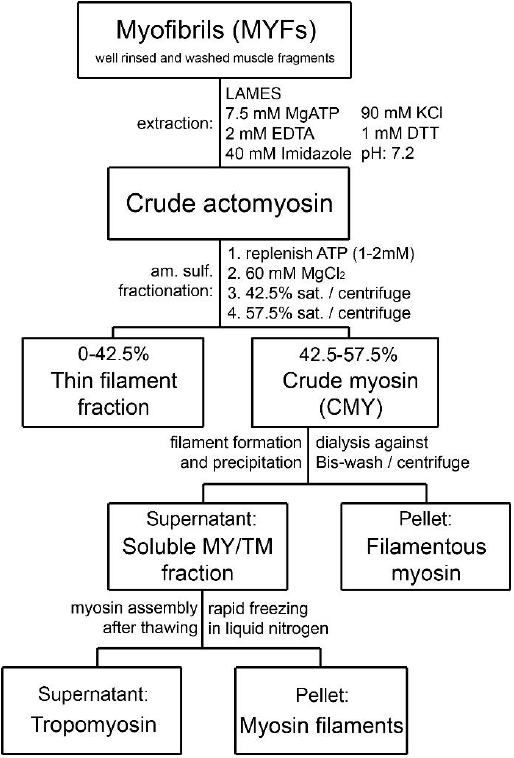
Figure 1. Schematic diagram of the purification steps developed for bovine tracheal smooth muscle myosin starting from isolated myofibrils. The approach was originally developed for gizzard muscle [18].